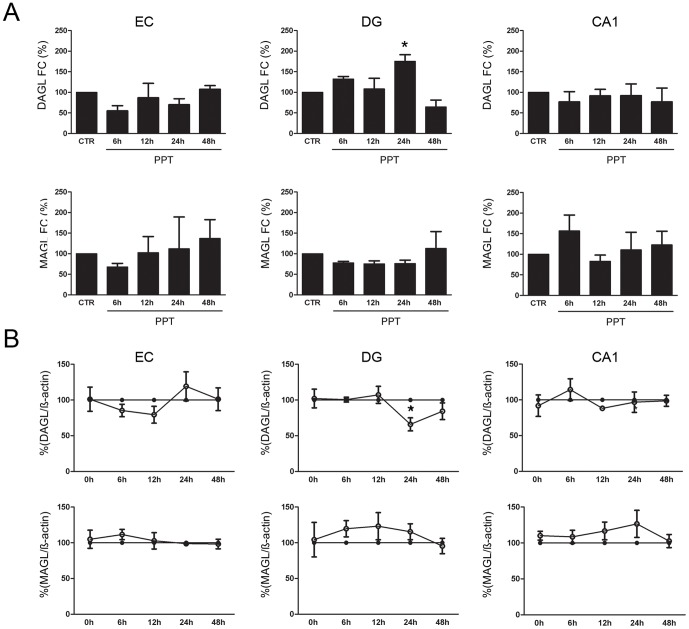
Enzymatic regulation of 2-AG after PPT.(A) Dagl and Magl mRNA regulation after PPT in the entorhinal cortex and the hippocampus after PPT. Dagl was increased after 24 hpl of PPT in the DG. (n = 3, *p <0.05) (B) DAGL (open cycles) and MAGL (open cycles) protein regulation after PPT in the entorhinal cortex and the hippocampus after PPT. DAGL was decreased after 24 hpl of PPT in the DG compared to the respective control (closed cycles). (n = 3, *p<0.05).